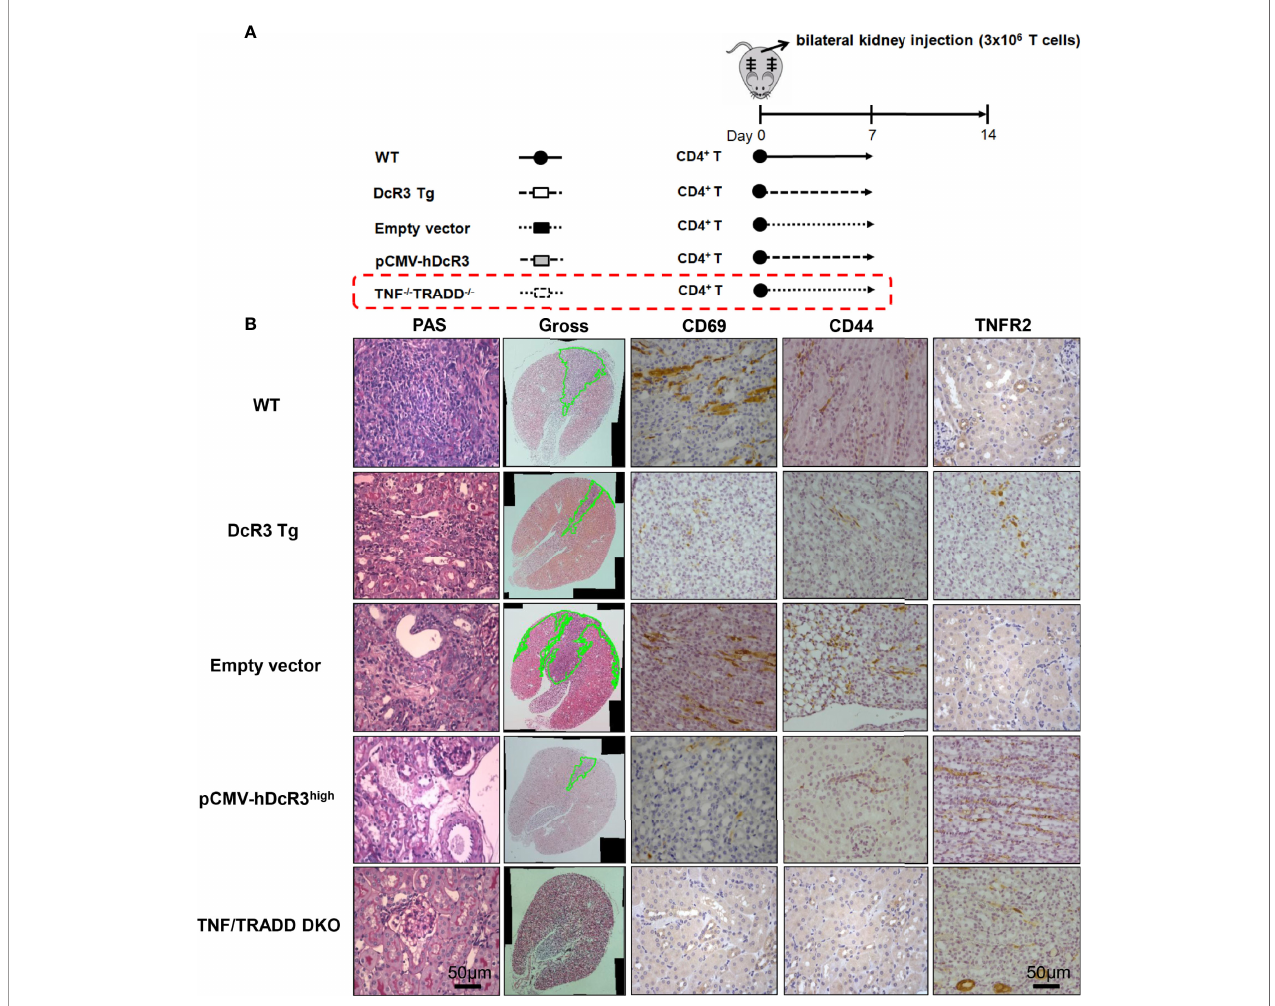
FIGURE 6 | Transgenic decoy receptor 3 (DcR3 Tg), tumor necrosis factor (TNF)/TNF receptor-associated factor 1-associated death domain protein (TRADD) double knockout (DKO), wild-type (WT) mice with empty vector or human DcR3 plasmid injection were tested to verify the presence or absence of TNF/TRADD signaling pathway during TNFR2 phenotype. (A) The mice were divided into fi ve groups including WT, DcR3 Tg, and WT mice with hydrodynamics-based gene delivery through the tail vein with empty vector or pCMV-hDcR3. All fi ve groups concurrently received 3 × 10 6 activated T-cell injections in the bilateral kidney cortex. (B) Periodic acid – Schiff, CD69, CD44, and TNFR2 immunohistochemical staining of WT, DcR3 Tg, and TNF/TRADD DKO mice and mice with empty vector or hDcR3 plasmid